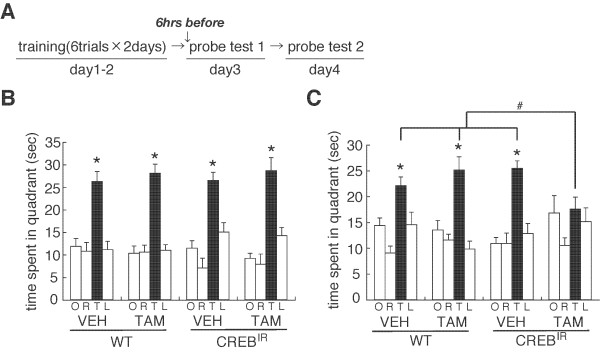
Role of CREB-mediated transcription in the reconsolidation of spatial memory. (A) Experimental design. (B) Probe trial at day 3 (PT 1) (WT/VEH, n = 12; WT/TAM, n = 9; CREBIR/VEH, n = 9; CREBIR/TAM, n = 10). *P < 0.05, time spent in the TQ vs. time spent in the other quadrants by post hoc Newman-Keuls test after significant one-way ANOVA. (C) Probe trial at day 4 (PT 2). *P < 0.05, time spent in the TQ vs. time spent in the other quadrants by post hoc Newman-Keuls test after significant one-way ANOVA. #P < 0.05, comparisons of searching scores in the TQ among the experimental groups of mice. Error bars are SEM. Time spent (s) in target (T), adjacent left (L), adjacent right (R), and opposite (O) quadrants during the probe trial is shown.